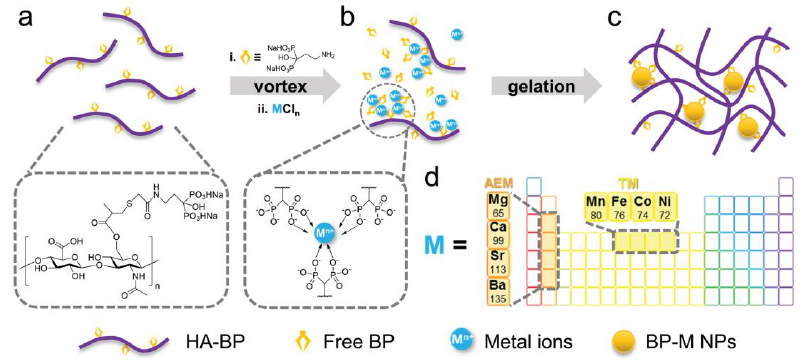
Figure 3. The structure of self-assembled HA-BP-M nanocomposite hydrogels ( a – c ) and representa- tive elements ( d ). (Reprinted with permission of John Wiley and Sons from